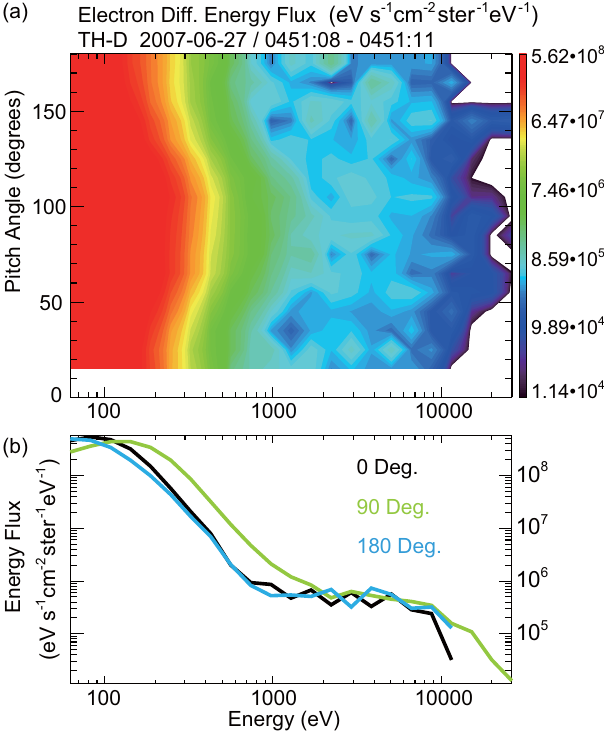
Figure 9. (a) Electron pitch-angle versus energy spectrogram and (b) energy distributions at the pitch angles 0, 90, and 180 ◦ , obtained in the FTE by THD at 04:51:08–04:51:11UT. The field-aligned and anti-field-aligned fluxes are roughly balanced especially at higher energies, indicating that the field lines in the FTE are partly